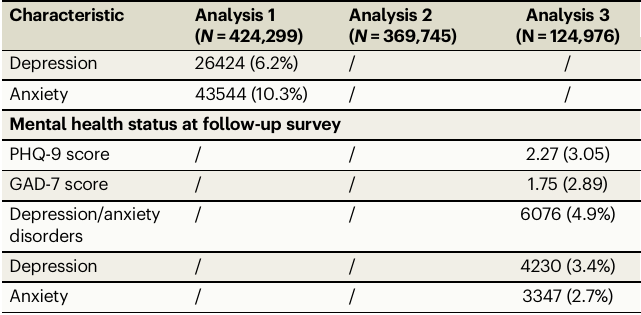
Table 1 | Characteristics of study participants